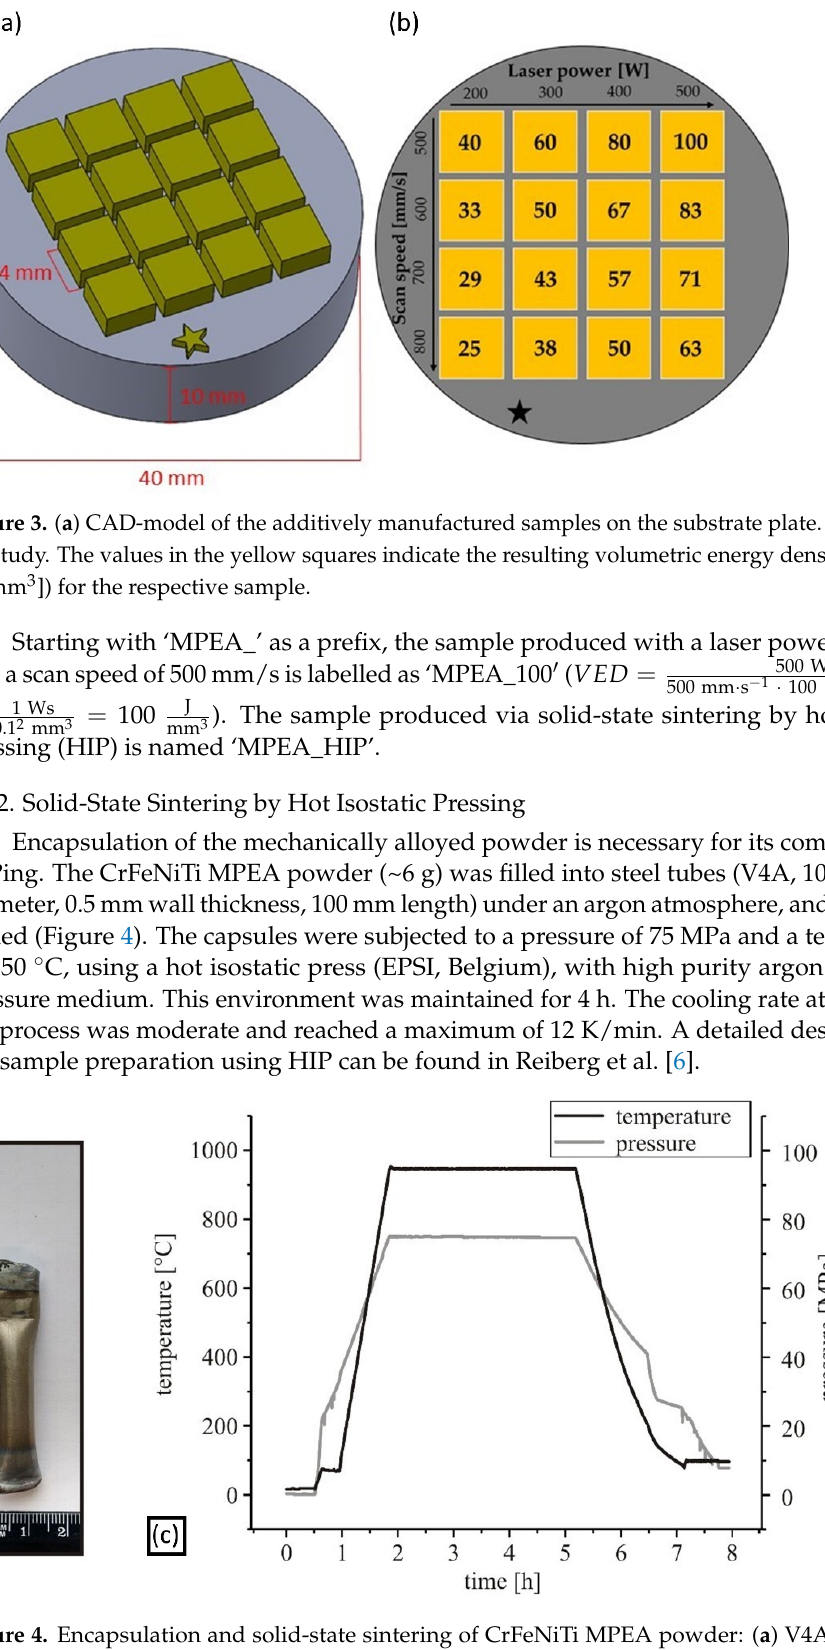
Figure 4. Encapsulation and solid ‐ state sintering of CrFeNiTi MPEA powder: ( a ) V4A ‐ tube filled with MPEA powder, ( b ) sealed capsule, ( c ) temperature and pressure cycle in HIP for densification of the encapsulated powder.